Question: Does the figure show an increasing or a decreasing trend?
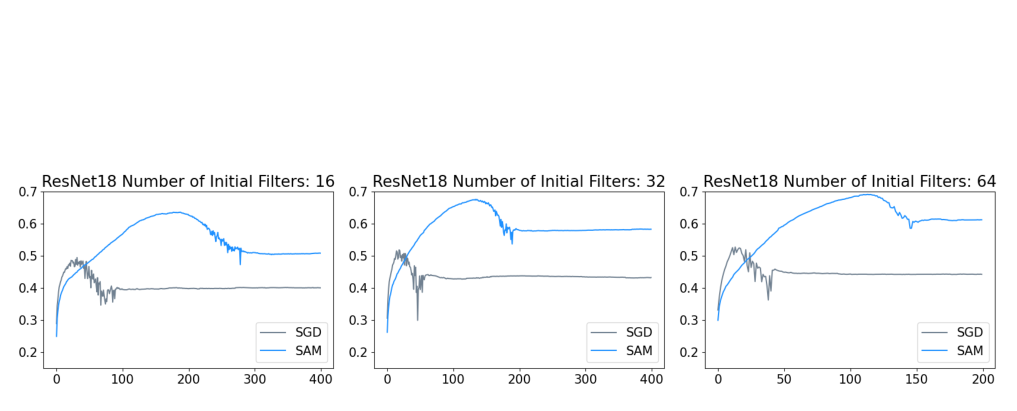
Answer: increasing